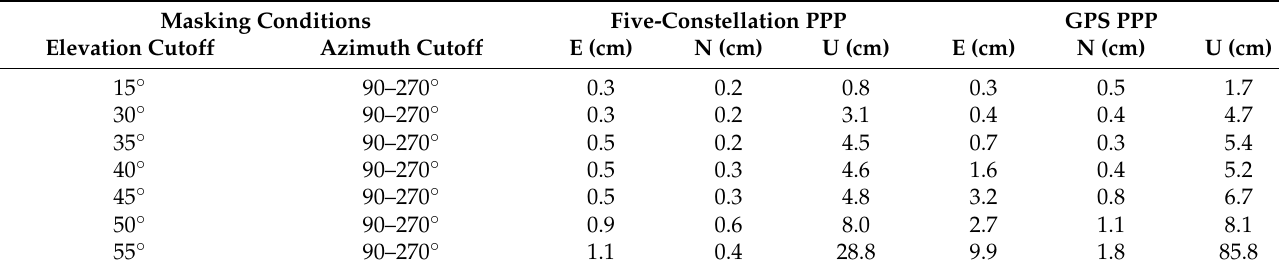
Table 3. RMS values of the estimated